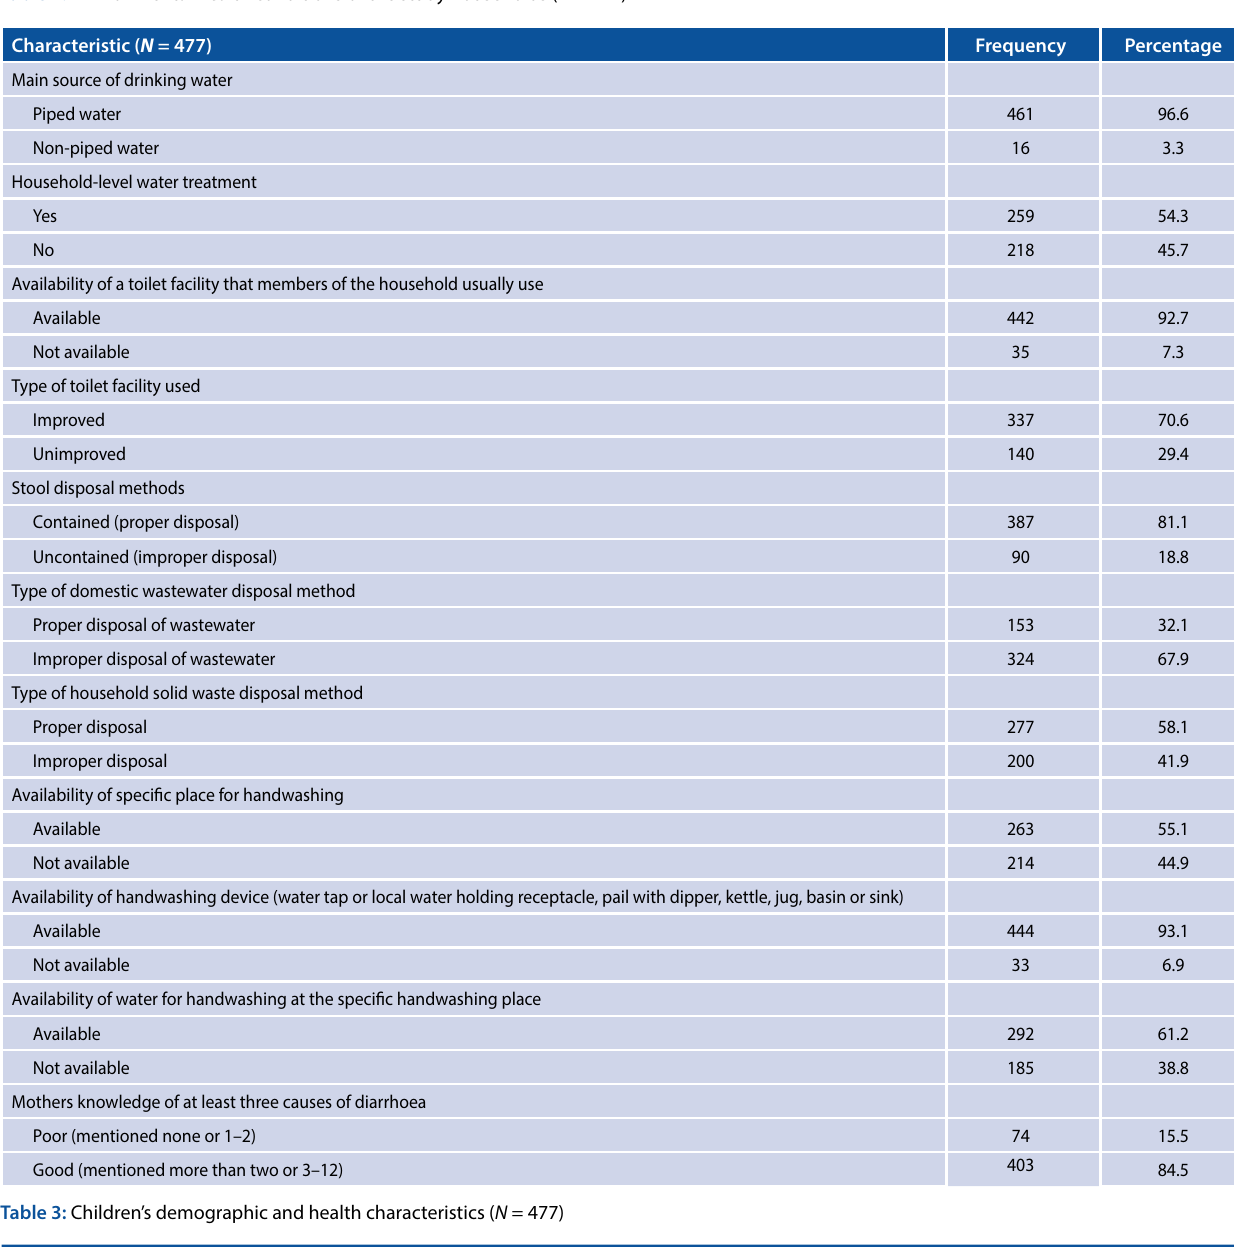
Table 2: Environmental health conditions of the study households ( N = 477) Characteristic ( N = 477)